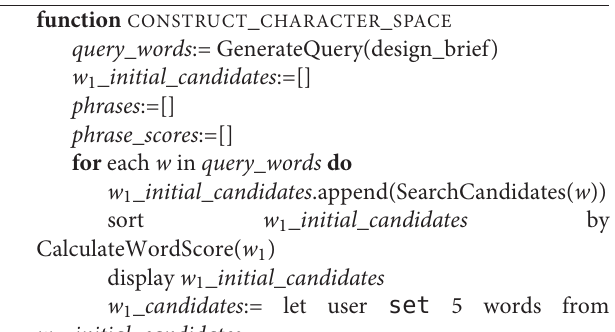
Algorithm 1: Character space